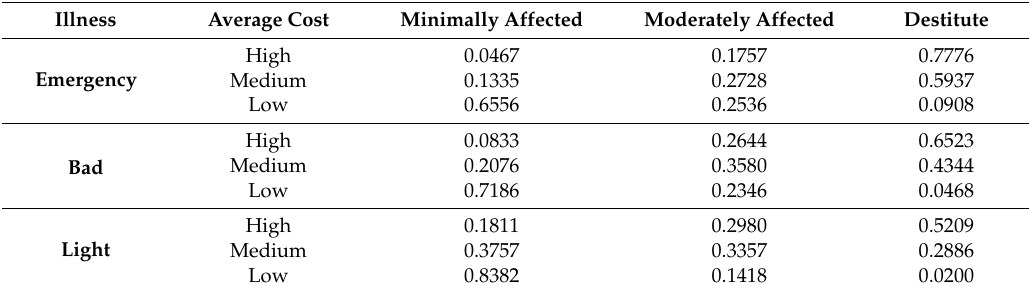
Table 7. Probabilities of financial burden following cost levels and illness.